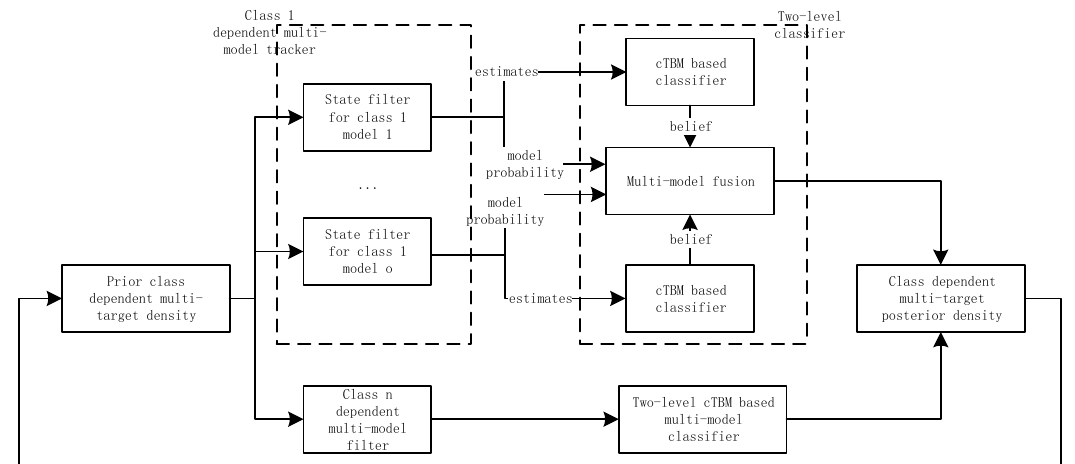
Figure 2. Algorithm flow